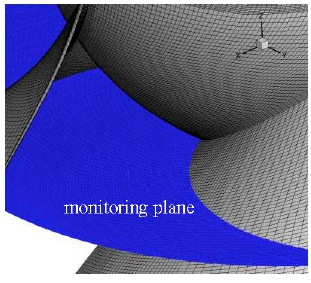
Figure 8. Monitoring plane of mass flow rate.